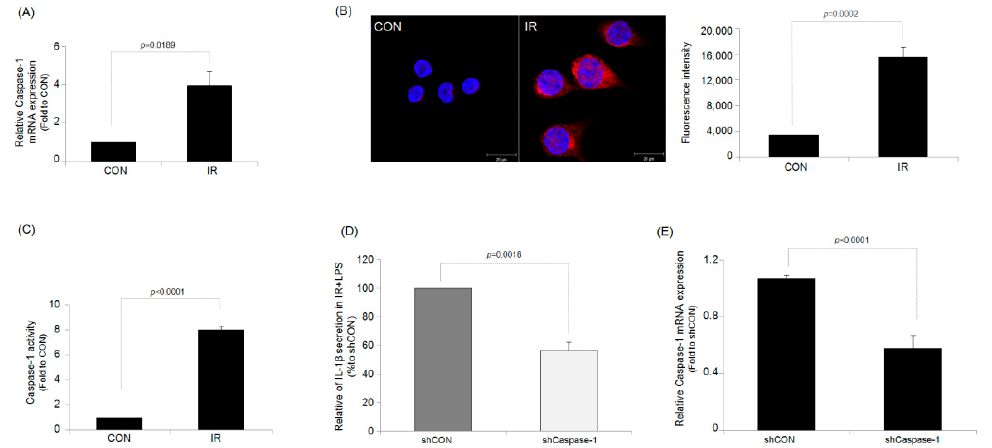
Figure 3. Ionizing irradiation (IR) increases the caspase-1 activity of RAW264.7 macrophage cells. ( A ) mRNA and ( B ) protein expression of caspase-1 in RAW264.7 macrophages. ( C ) Changes in caspase-1 activity were measured. ( D ) Changes in IL-1 β production in RAW264.7 macrophage cells transfected with either caspase-1 shRNA or scramble shRNA. ( E ) Real-time PCR data of caspase-1 mRNA. Results are expressed as mean ± S.E.M.